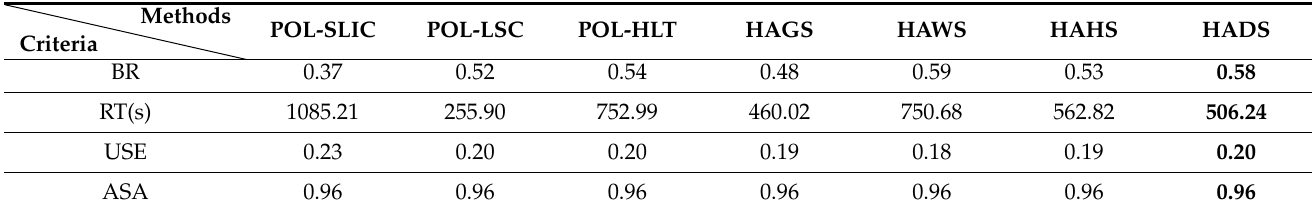
Table 6. Four evaluation criteria for 7 methods based on the filtered data set 5 using Lee filter with w = 5.